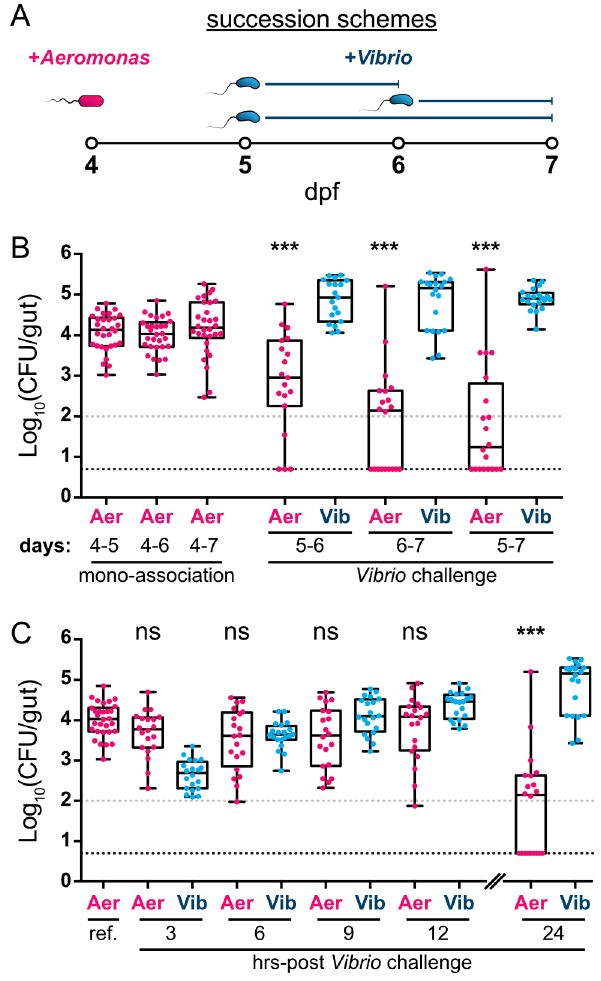
Fig 1. Aeromonas and Vibrio exhibit a competitive interaction within the larval zebrafish intestine. (A) Graphical overview of succession schemes used to characterize Aeromonas – Vibrio interactions. Aeromonas is allowed to colonize GF larvae at 4 dpf followed by addition of Vibrio to the water column at 5 or 6 dpf for 24 or 48 hr prior to enumeration of abundances by dissection and serial plating techniques. (B, left) Aeromonas abundances after different mono-association durations and (B, right) Aeromonas and Vibrio abundances after different Vibrio challenge periods. Statistical significance of Aeromonas abundances after Vibrio challenge compared to respective mono-association reference populations (i.e., 5 – 6 versus 4 – 6; 6 – 7 versus 4 – 7; 5 – 7 versus 4 – 7) was determined by an unpaired t test. (C) Time course analysis of Aeromonas and Vibrio abundances determined by dissection and plating at 3 hr intervals over a 12 hr period starting at 6 dpf. Additionally plotted are an Aeromonas mono-association reference population and 24 hr Aeromonas and Vibrio populations previously plotted in 1B (4 – 6 and 6 – 7, respectively). Statistical significance of Aeromonas abundances to the mono-association reference population (ref.) was determined by an unpaired t test. CFU = colony-forming units; *** = p < 0.0001; ns = not significant; n > 19/condition. Gray and black dashed lines in panels B and C denote limits of quantification and detection, respectively. Underlying data for B and C are provided in S1